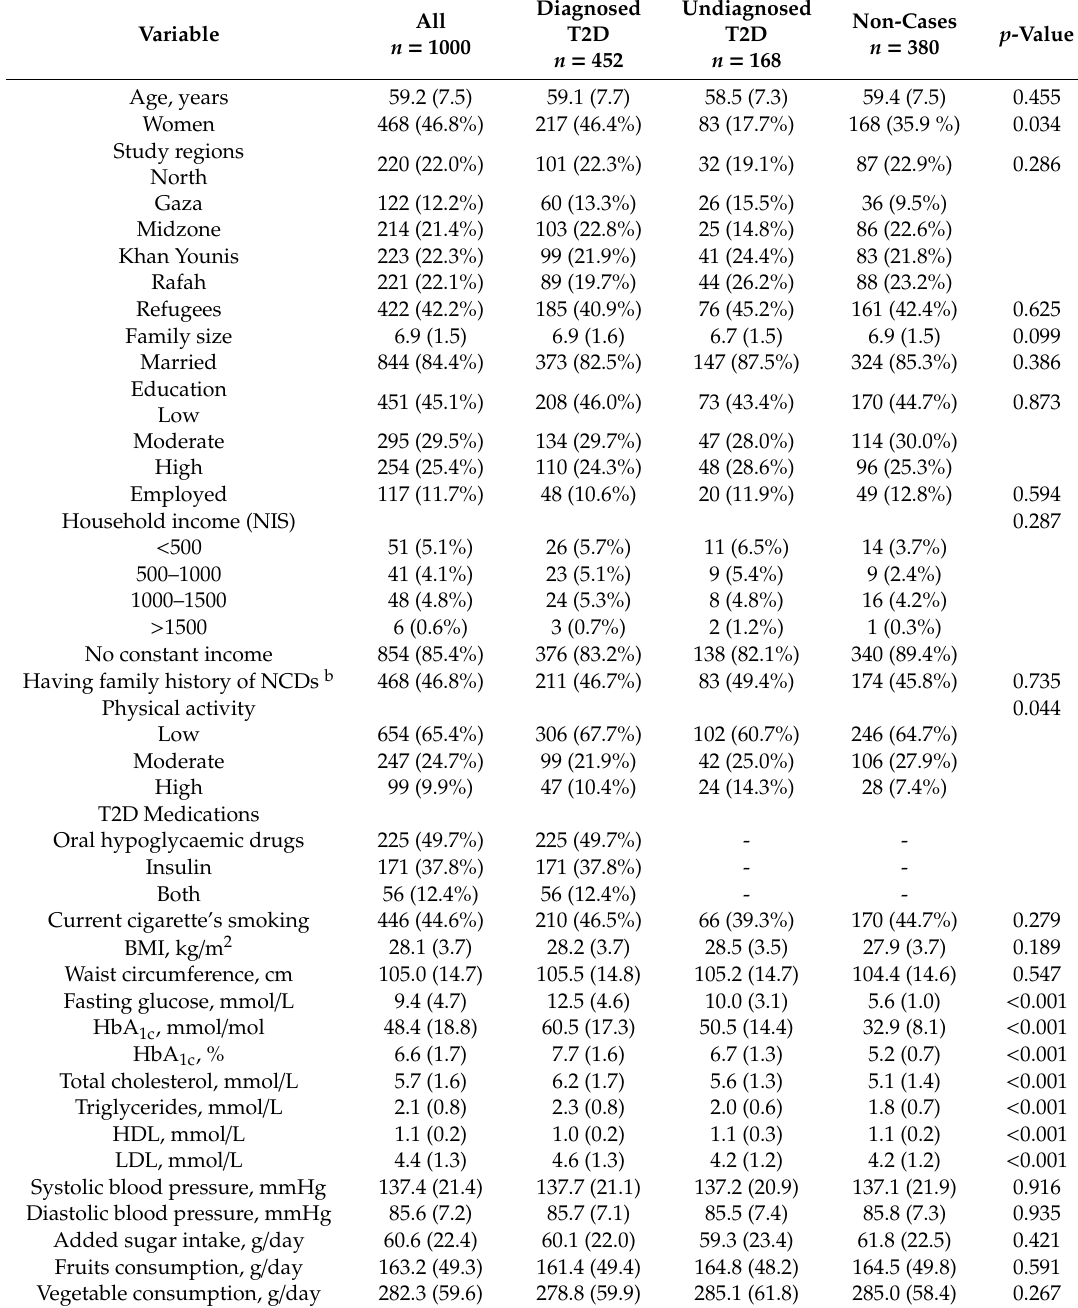
Table 1. Characteristics of study participants.